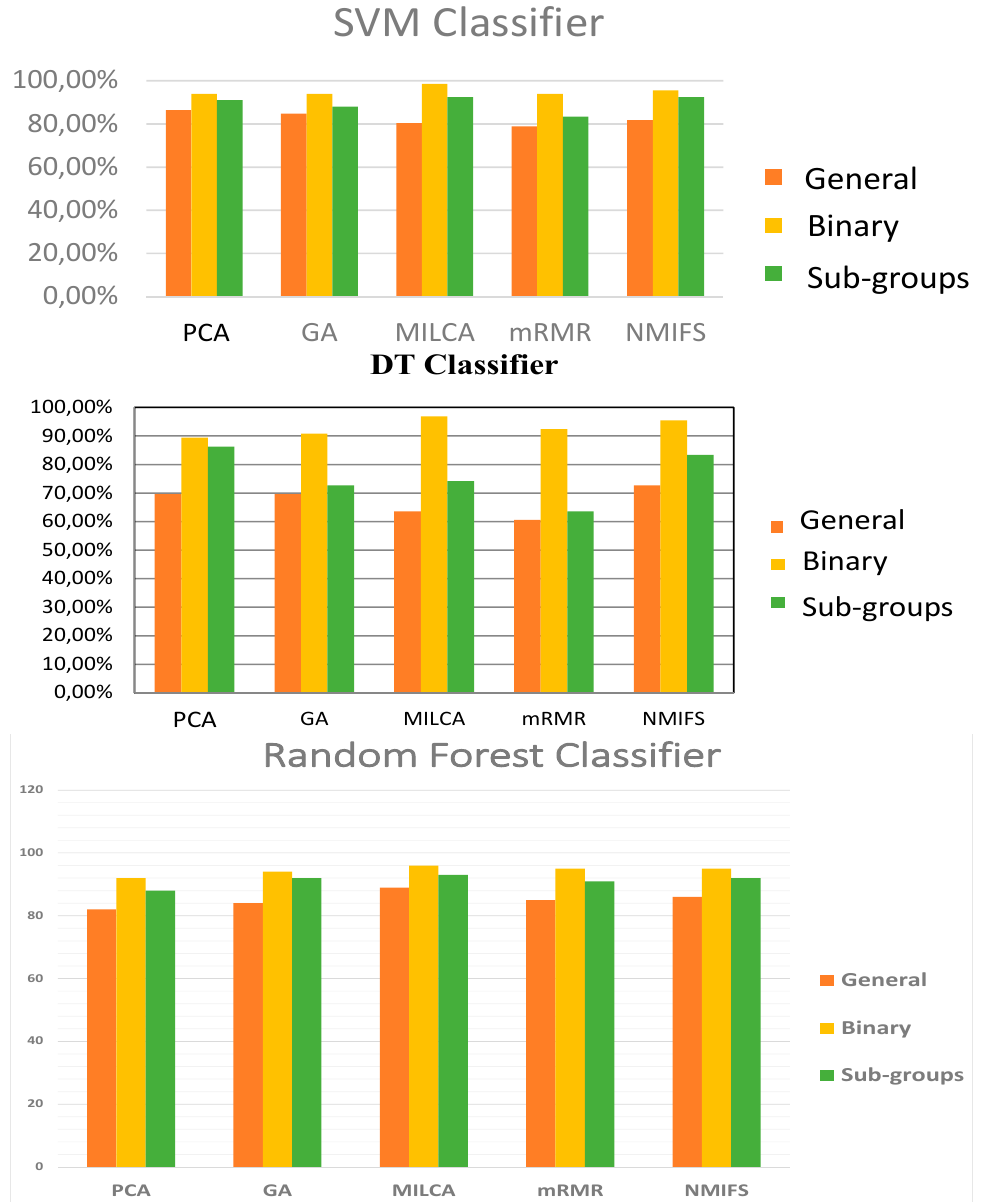
Figure 5. Behavior of different classifiers, using different sets of input variables and different numbers of output